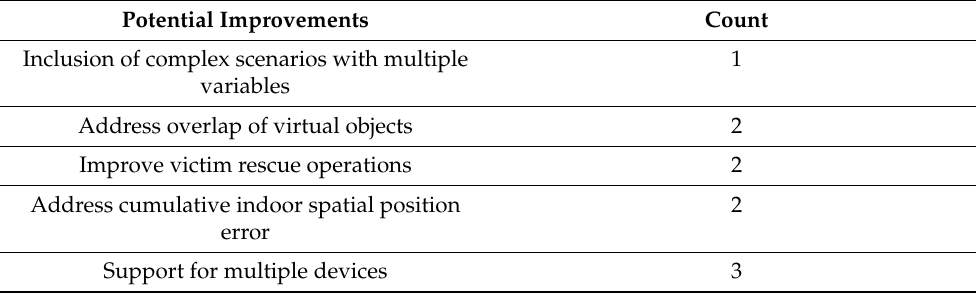
Table 4. Potential system improvements cited by the